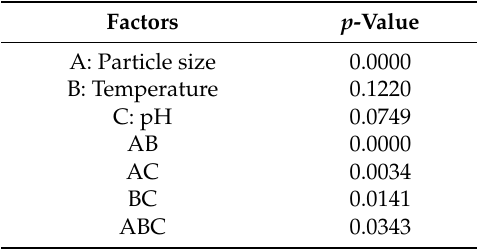
Table 4. Results from the ANOVA for CBZ